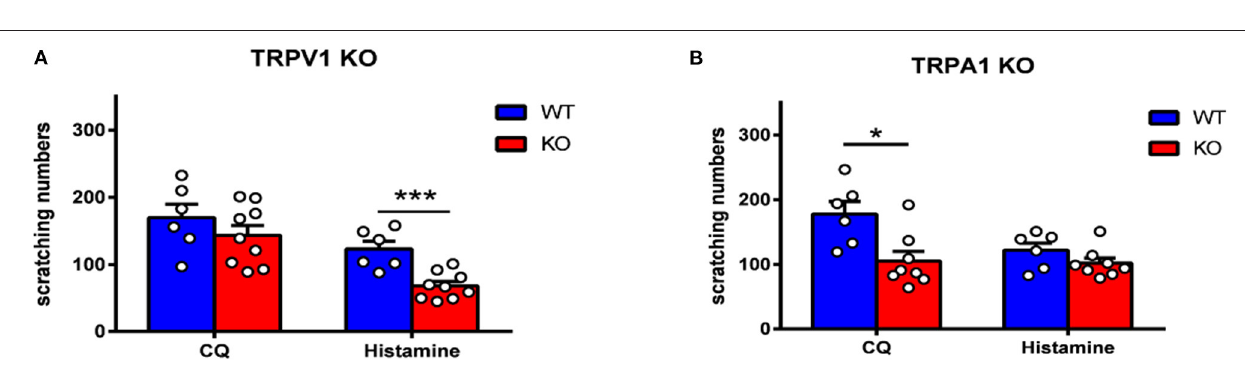
neurons in the primary sensory ganglia that distinctly mediate itch and pain. However, whether ZBTB20 regulates itch-related TRP channels has not been reported. Our data demonstrated that both histamine and CQ increase the mRNA expression of ZBTB20, TRPV1, and TRPA1 in the TG, providing evidence that ZBTB20 probably modulates TRP channels in itch-specific